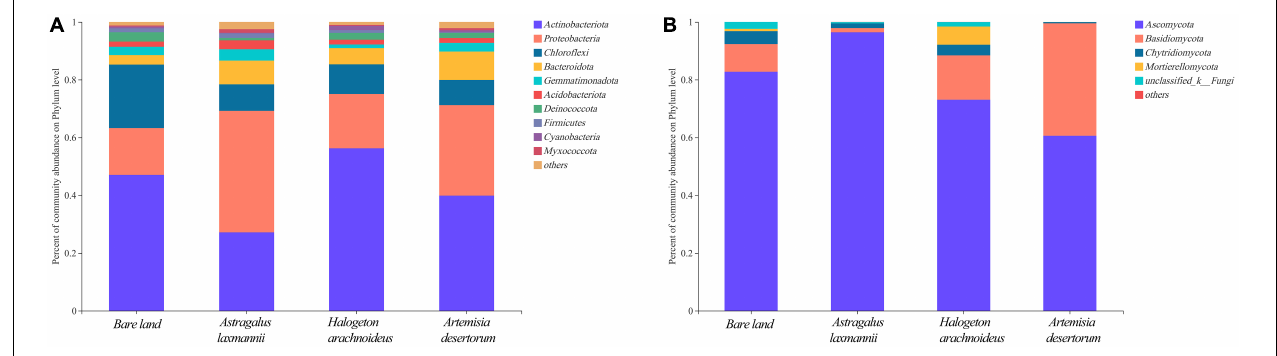
FIGURE 5 | Horizontal abundance characteristics of (A) bacterial and (B) fungal communities in soils from bare land and re-vegetated areas with different plant species.